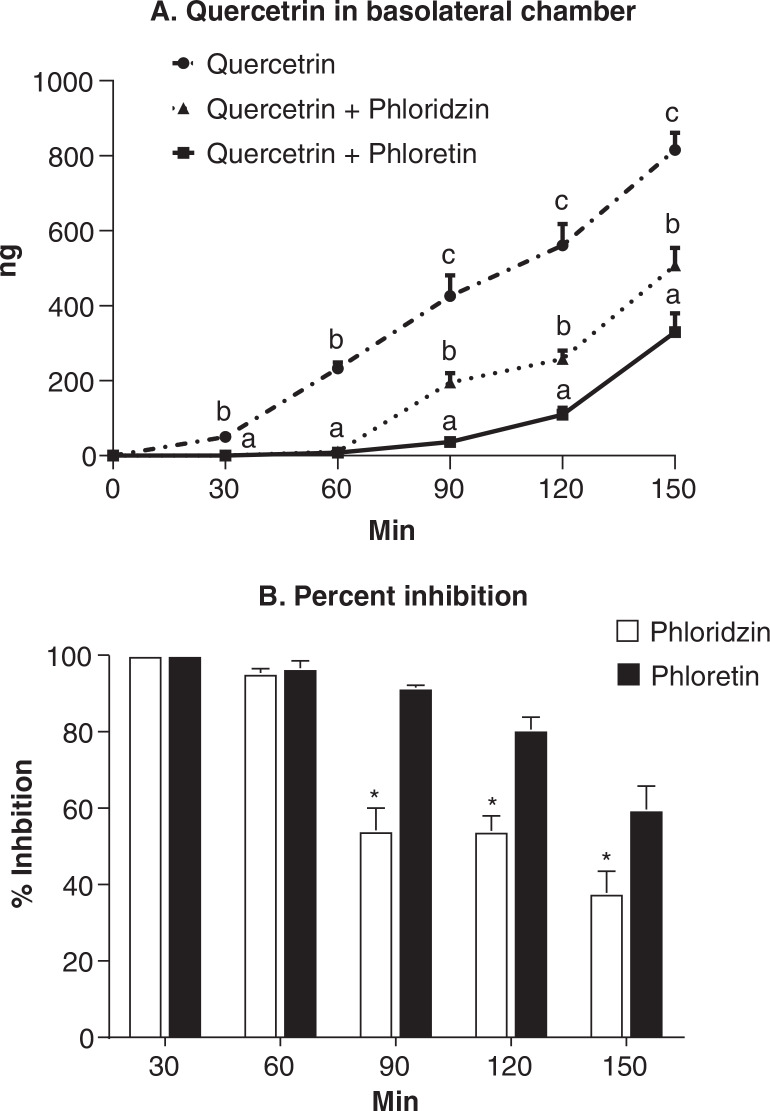
The apical to basolateral transport of quercitrin at 18 μg/mL by Caco-2 cells cultured in a Millicell (trans well) culturing system for 21 days and then pretreated with phloridzin and phloretin for 15 min, (A) time course of quercitrin transport and (B) percent inhibition of quercitrin transport. Quercitrin concentration is Phloridzin and phloretin is a non-specific, inhibitor of SGLT1 and GLUTT2, respectively. Vehicle containing no quercitrin was also administered but the data were shown in the figure because quercitrin was not detected. Quercitrin in the basolateral media is quantified using LC-MS at 30, 60, 90, 120, and 150 min post administration. The percent inhibition is calculated using the formula: (Q – Q+)/Q × 100%, where Q is the quercitrin concentration of the cells without the pretreatment of inhibitor and Q+ is quercitrin concentration of the cells with the pretreatment of inhibitor. Values are expressed as mean ± SD (n = 3). abcMeans at the same time points without sharing the same letter significantly differ (P < 0.05), tested by variance analysis of repeated measurement, followed by Fisher’s least significant difference (LSD) test with Bonferroni adjustment for multi-comparison. *Means at the same time points significantly differ (P < 0.05).